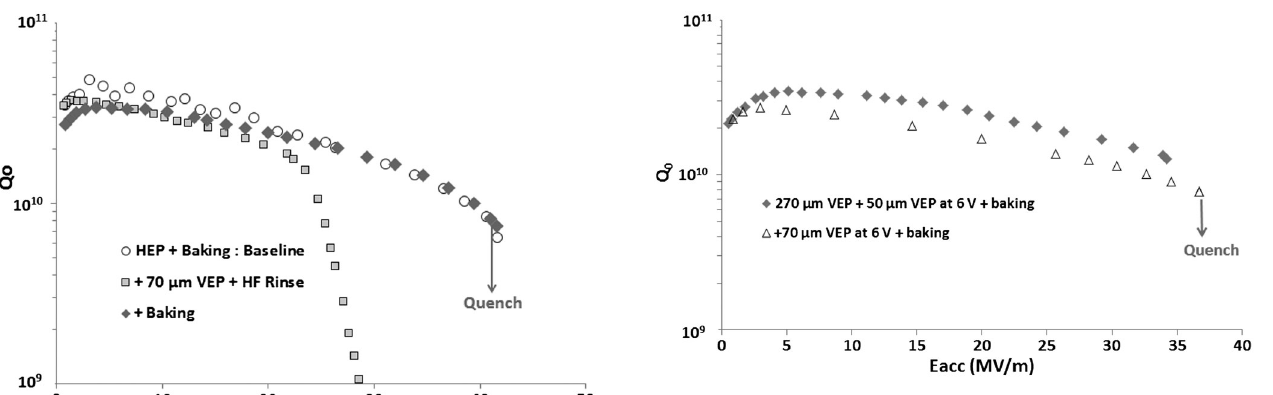
FIG. 4. Radio-frequency results of the “ 1AC3 ” cavity at